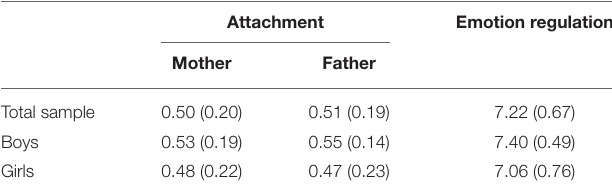
TABLE 1 | Means and standard deviations for attachment security and emotion